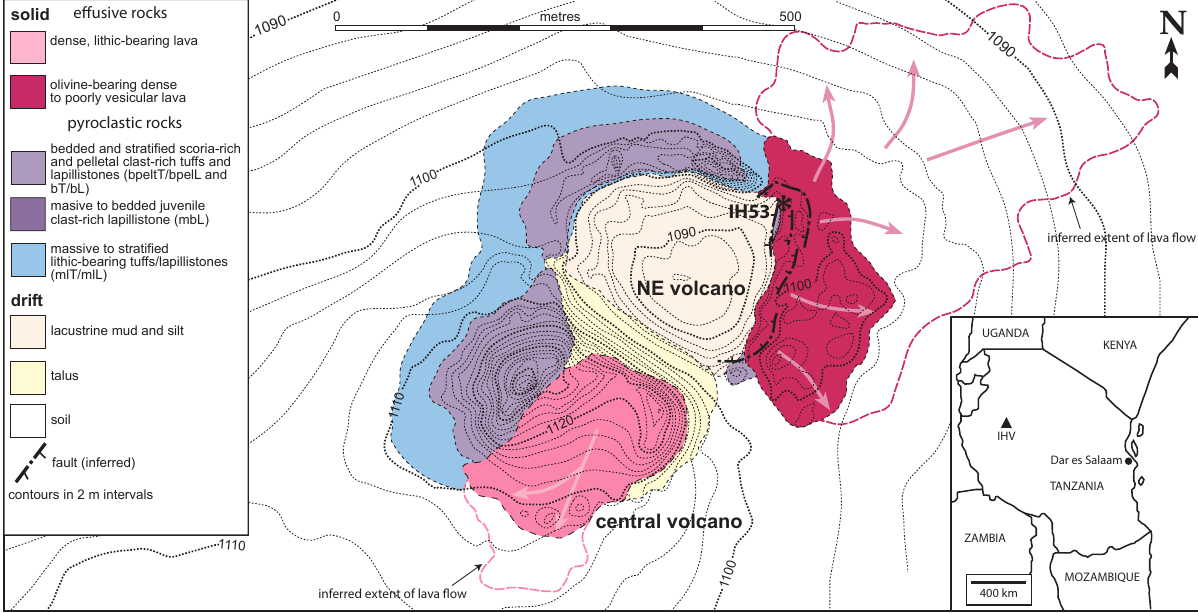
Figure 1. Map of Igwisi Hills volcanoes (IHV), showing the relative positions of the two northernmost volcanic edifices and the location of the lava (IH53) sampled in this study. The Igwisi Hills volcanoes are situated at latitude 4 ◦ 51 0 S, longitude 31 ◦ 55 0 E. Adapted from Brown et al.